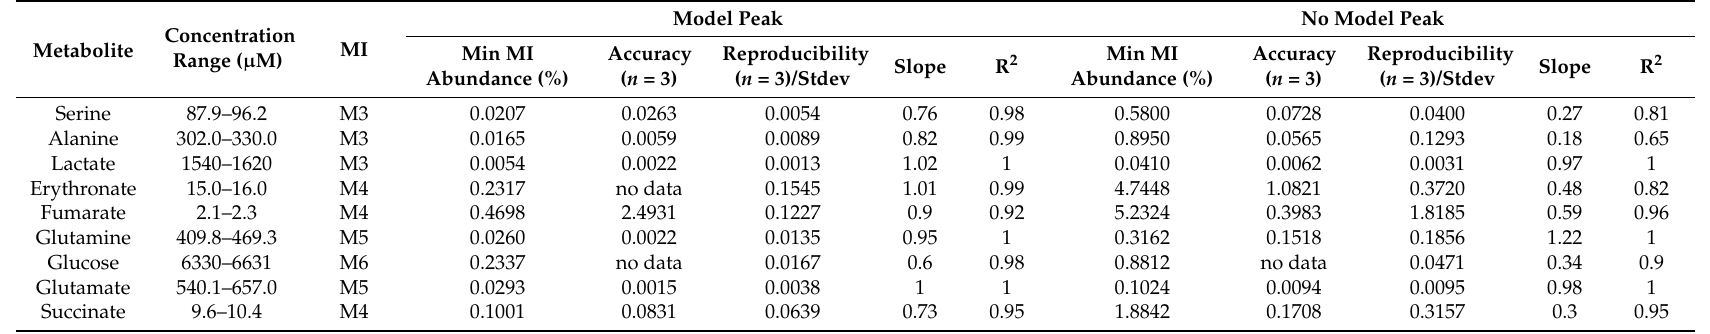
Table 1. MID calculation obtained from labeled A549 cell extract diluted in plasma (1:1000, 1:500, 1:200, 1:100, and 1:10) of the original 13 C enrichment) with model peak correction and without model peak correction; determination of accuracy (3 injections) and reproducibility (standard deviation, 3 extractions) of minimal MI abundance, slope and R 2 determined by regression